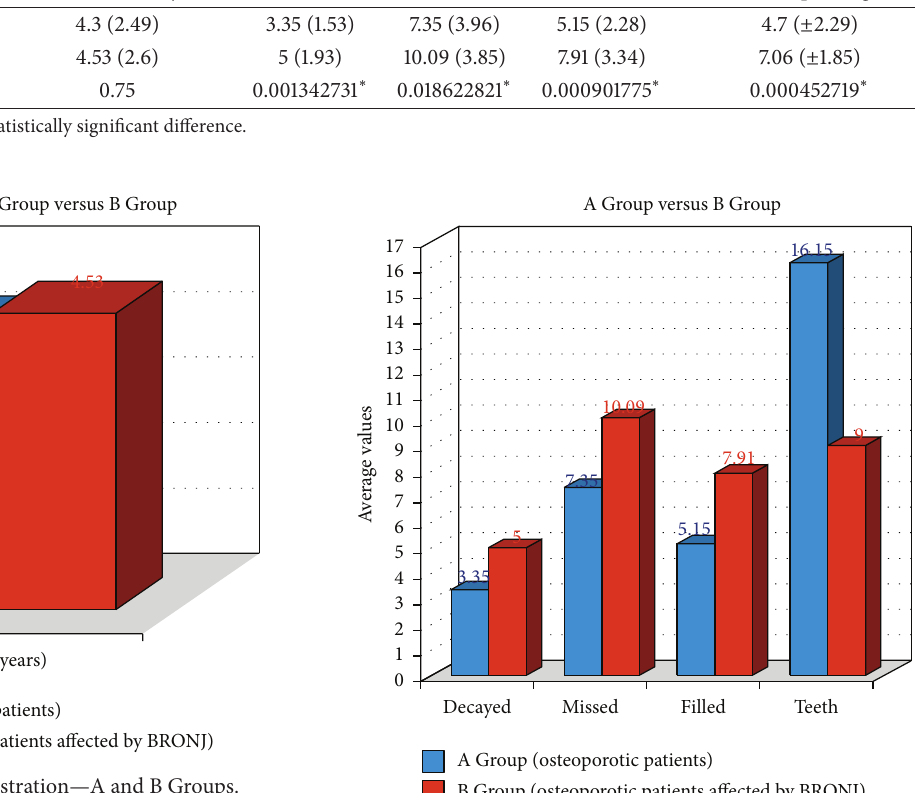
Figure 3: Years of BP administration—A and B Groups.